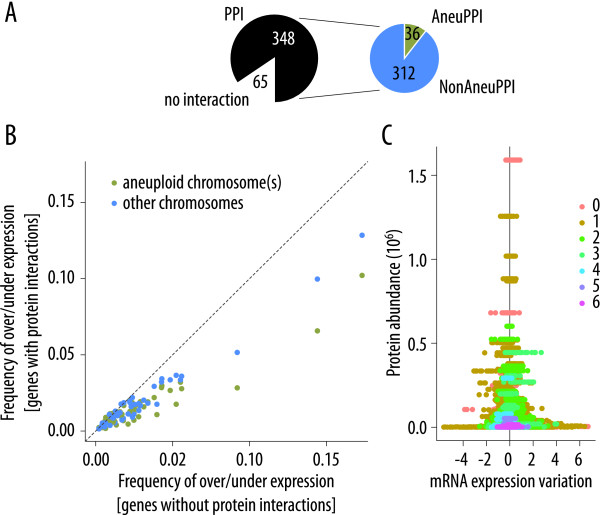
Correlation between protein-protein interactions and mRNA expression variation. (A) Definition of the three interaction datasets considered. PPI consists of all non-aneuploid chromosome genes coding for a protein with at least one interaction (348 genes out of 413 in the example considered here). Any genes with at least one protein interaction with a protein encoded on the aneuploid chromosome are in AneuPPI (36 here); all other members of PPI are placed in NonAneuPPI (312). (B) Plot of the frequency of the genes with increased or decreased mRNA expression (y-axis; 1.3-fold change, see Methods) coding for a protein interaction with a protein encoded either on an aneuploid chromosome, AneuPPI (green dots), or on a different chromosome, NonAneuPPI (blue dots), against the proportion of genes without interactions that showed changed mRNA expression for each aneuploidy microarray experiment (x-axis). (C) Scatter plot of protein abundance (protein molecules per cell) versus mRNA expression variation. High abundance proteins show low mRNA variation (Spearman rank correlation; P < 10-15). The number of protein-protein interactions is color-coded as illustrated by the legend at right. Proteins with a high degree of interaction are of both low abundance and low mRNA expression variation (Spearman rank correlations, P < 10-15).